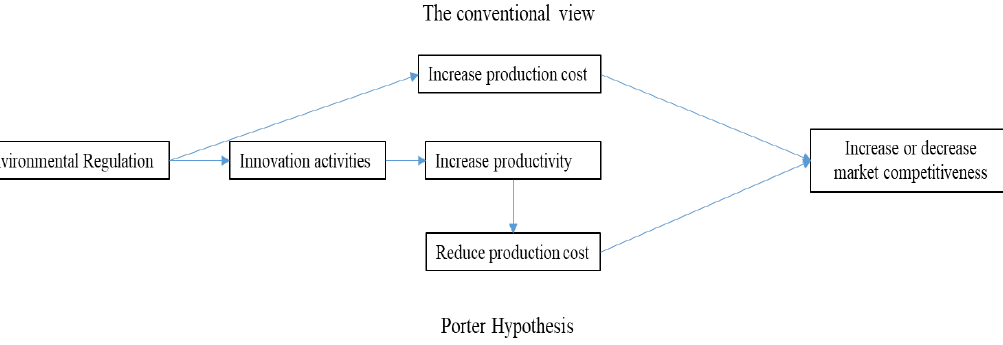
ff erences between the Porter hypothesis and conventional Figure 1. The similarities and differences between the Porter hypothesis and conventional views. Figure 1. The similarities and di